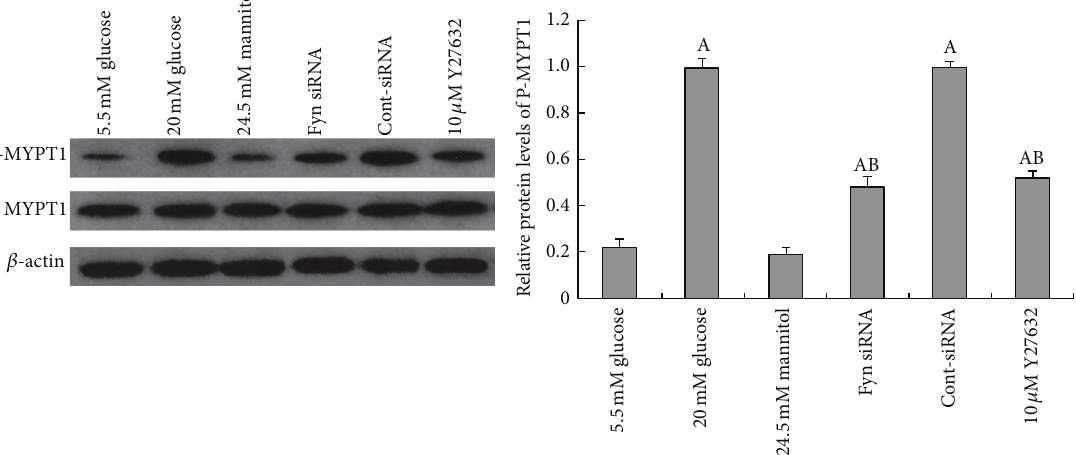
Figure 7: Western blotting analysis of alterations to ROCK activity in podocytes. ROCK activity was analyzed by determining the phosphorylation state of MYPT1, a downstream target of ROCK. The phosphorylation status of MYPT1 was significantly enhanced after 48-hour incubation with 30 mM glucose (lane 2) compared with cells incubated with 5.5 mM glucose (lane 1). Transfection with Fyn siRNA for 24 hours (lane 4) or pretreatment with 10 𝜇 M Y27632 for 30 minutes (lane 6) decreased MYPT1 phosphorylation. Control podocytes were treated with Cont-siRNA (lane 5) or 5.5 mM glucose plus 24.5 mM mannitol (lane 3). Values denote the mean ± SD; A 𝑃 < 0.05 versus 5.5 mM glucose and B 𝑃 < 0.05 versus 30 mM